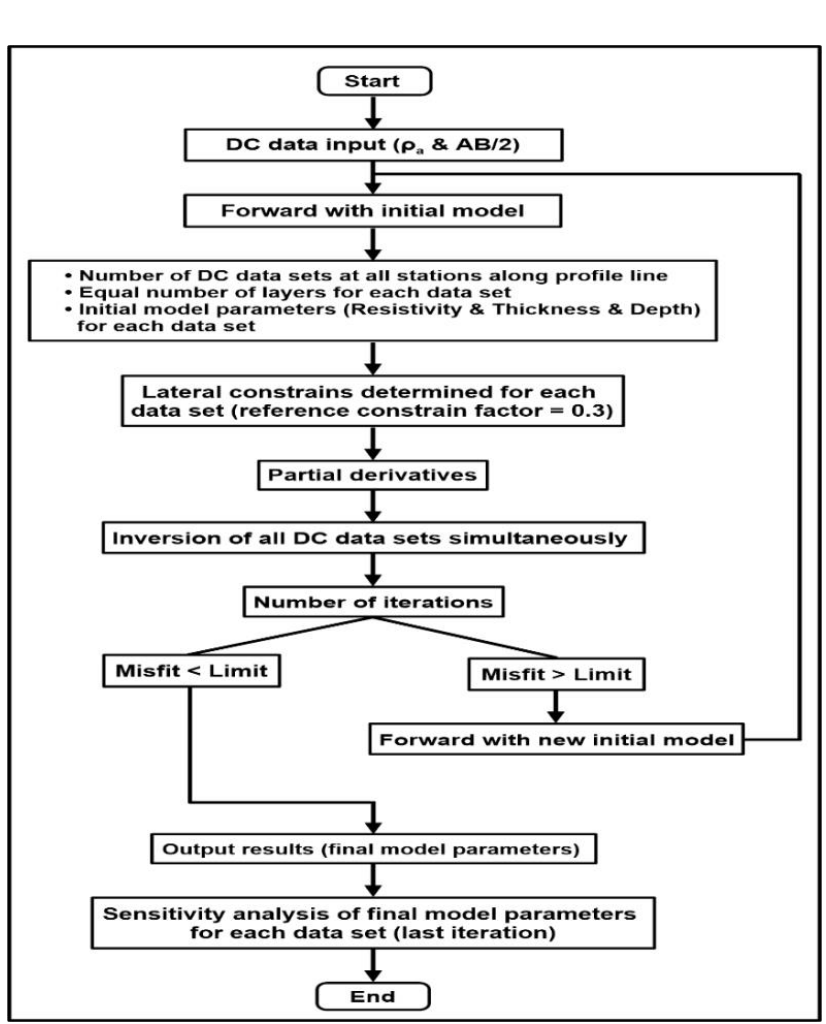
Figure 5. Flowchart of the Aaarhus algorithm.